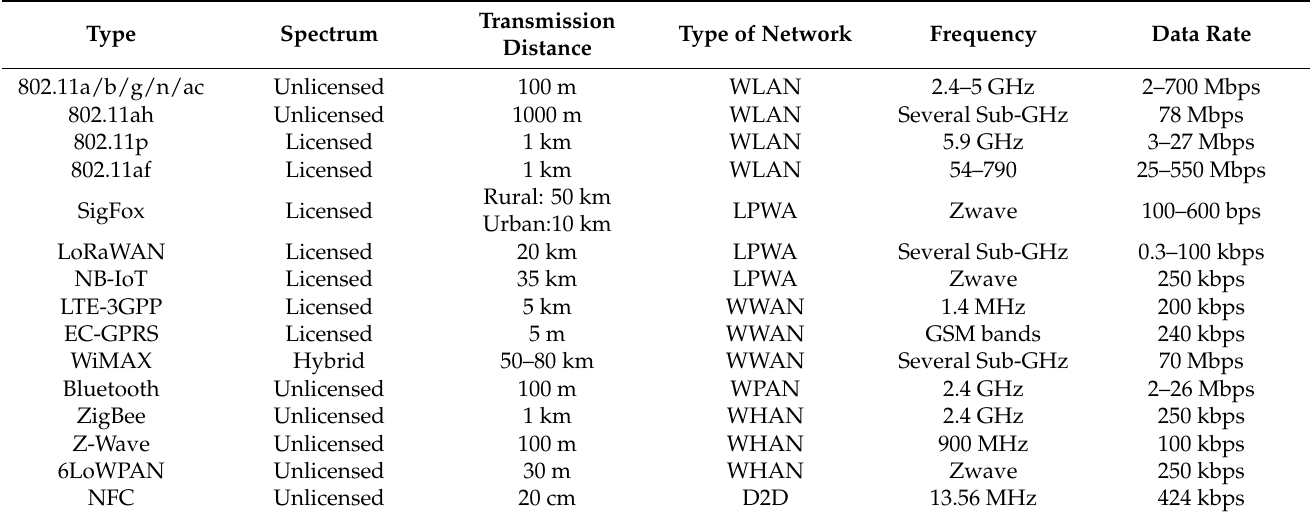
Table 1. Some typical communication technologies for smart